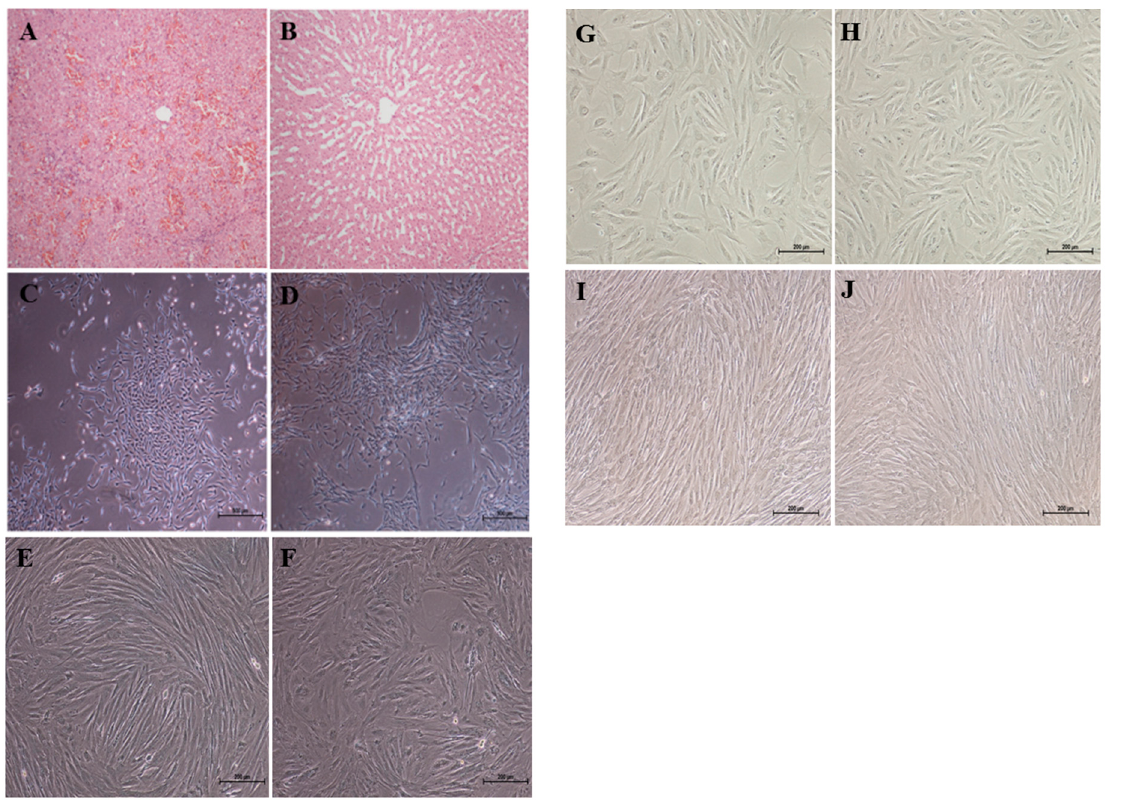
Figure 1. Liver tissue specimens were collected for histochemistry and immunohistochemistry to confirm the acute liver failure (ALF) group and normal group. Morphology of ALF-derived adipose-derived mesenchymal stem cells (ADMSCs) and normal ADMSCs under a light microscope. ( A ) Extensive hepatocyte necrosis and hemorrhaging and a collapsed hepatic lobular structure were observed in the post-mortem liver tissue specimen of the ALF group; ( B ) The normal liver tissue showed normal liver lobule structures; ( C ) Morphology of ALF-derived ADMSCs at day 15; ( D ) Morphology of normal ADMSCs at day 15; ( E ) Morphology of ALF-derived ADMSCs at passage 5; ( F ) Morphology of normal ADMSCs at passage 5; ( G ) Morphology of ALF-derived ADMSCs at passage 10; ( H ) Morphology of normal ADMSCs at passage 10; ( I ) Morphology of ALF-derived ADMSCs at passage 15; ( J ) Morphology of normal ADMSCs at passage 15; ( A , B ) (Hematoxylin and eosin (HE), ×10); ( C , D ) Scale bars = 500 μ m; ( E – J ) Scale bars = 200 μ m; FADMSCs (ADMSCs derived from ALF pigs) are ADMSCs derived from ALF pigs, and NADMSCs (ADMSCs derived from normal pigs) are ADMSCs derived from normal pigs in all